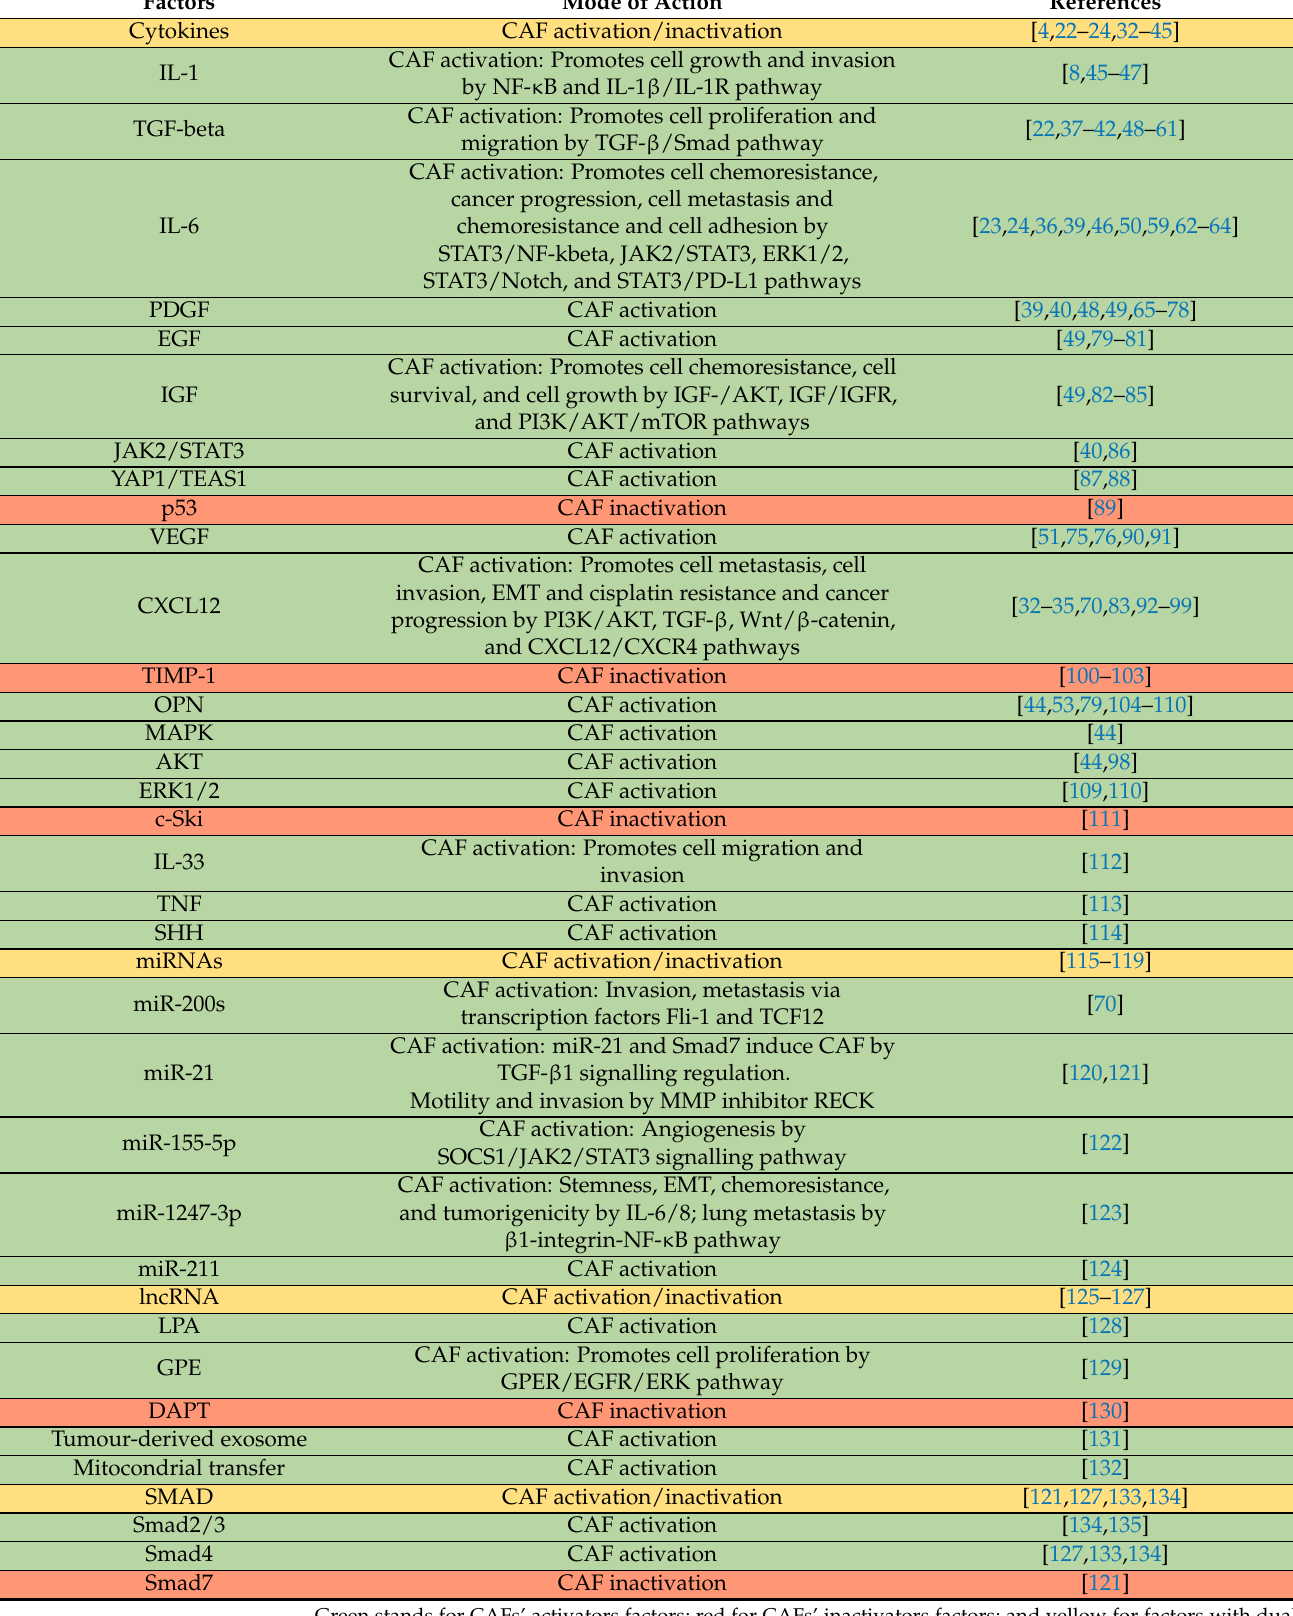
Table 1. Tumour cell’s secreted factors and their functions over